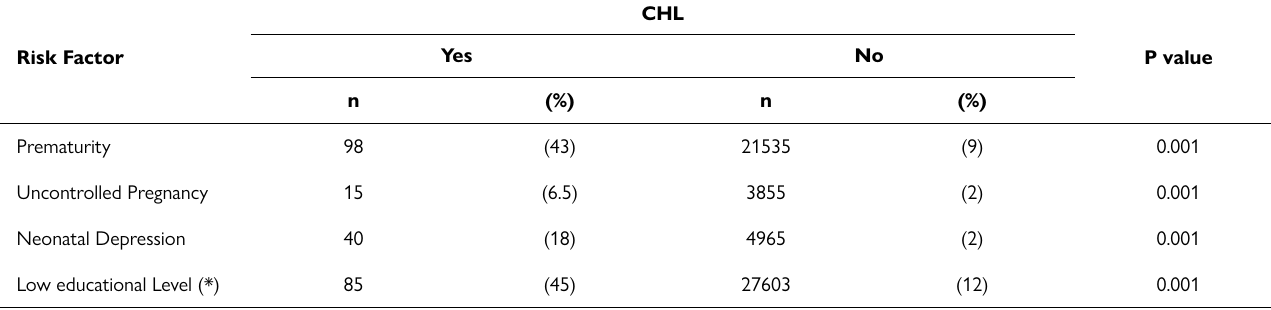
Table 5. Risk factors related to congenital hearing loss